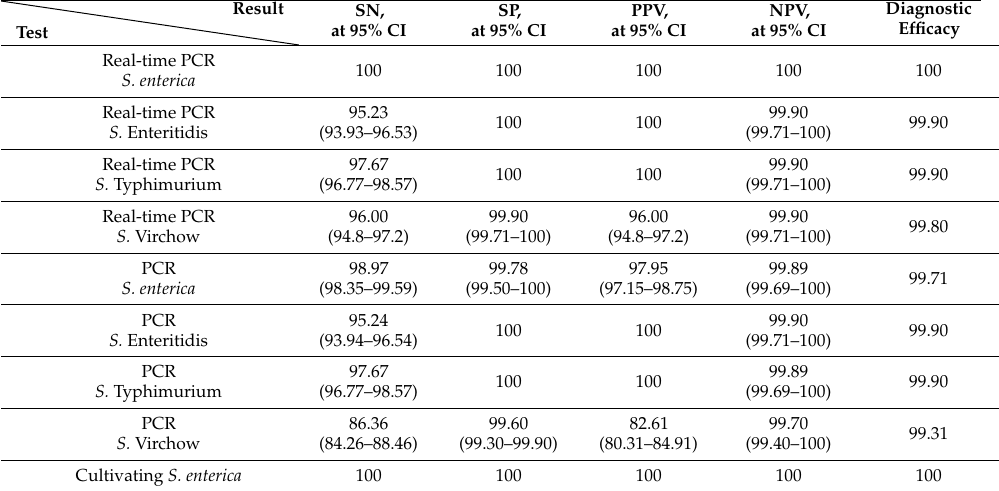
Table 5. Comparison of various tests for the detection of Salmonella enterica and its types S. Enteritidis